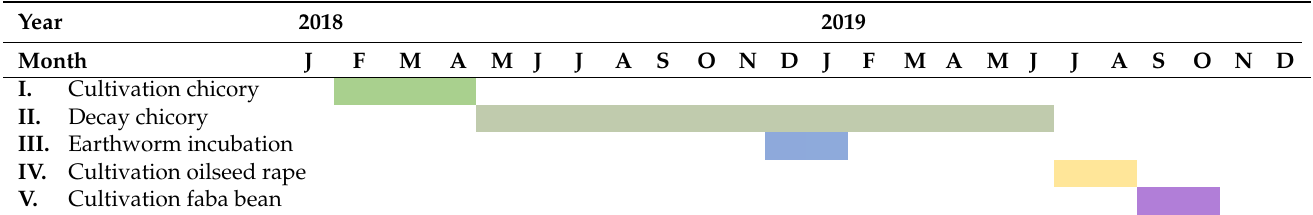
Table 1. Timeline with the different stages of the